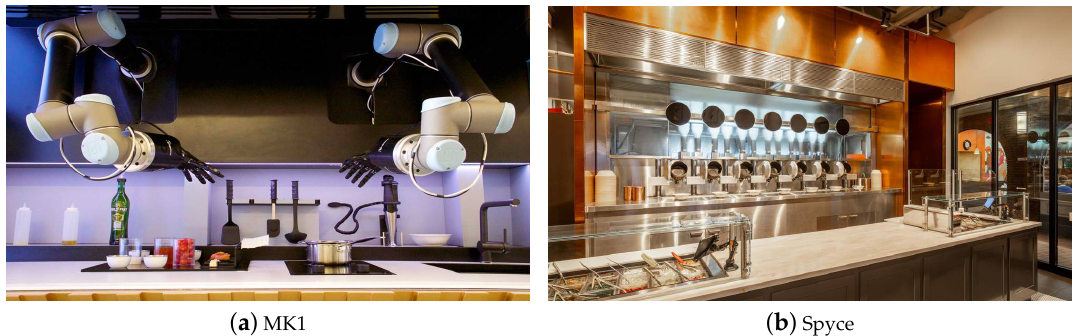
Figure 6. Two different examples of robotchefs. ( a ) MK1. The robochef from Moley Robotics that cooks with the skill and flair of a master chef. ( b ) Spyce. The restaurant with a robotic